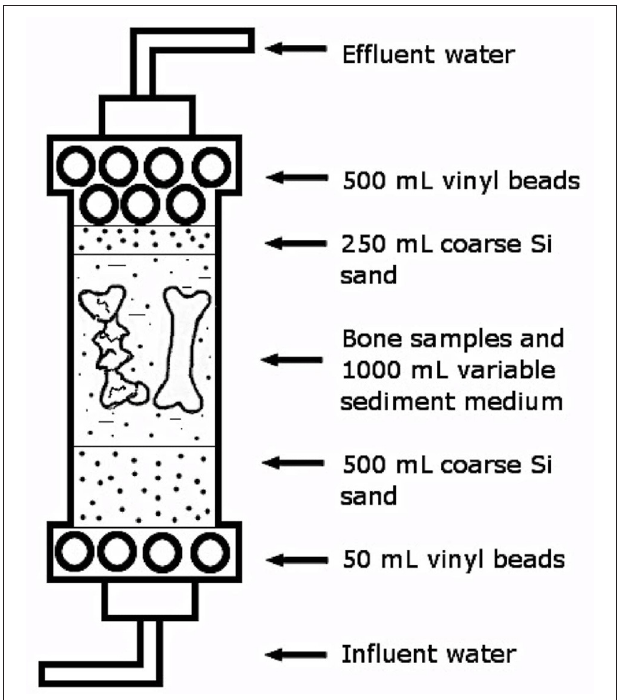
FIGURE 1 | Schematic of PVC flow-through columns used in experiment.